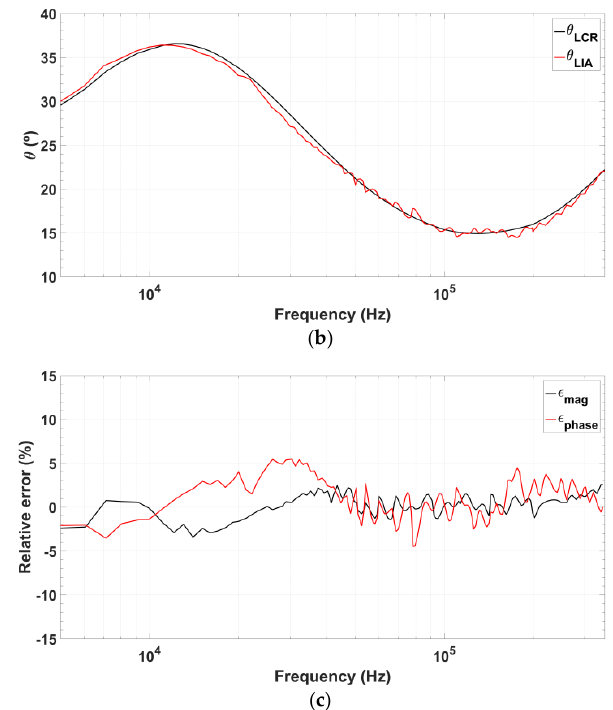
Figure 17. Comparison of the impedance values measured using the signals from the proposed quadrature oscillator prototype (red) and those obtained using the commercial 8101G LCR-meter (black) for impedance values measured in protein detection, but employing a different gain setup for the three frequency ranges: low (5–50 kHz), medium (50–250 kHz), and high (250–350 kHz). ( a ) Recovered impedance magnitude; ( b ) Recovered impedance phase, and ( c ) Relative error of both magnitude and phase.